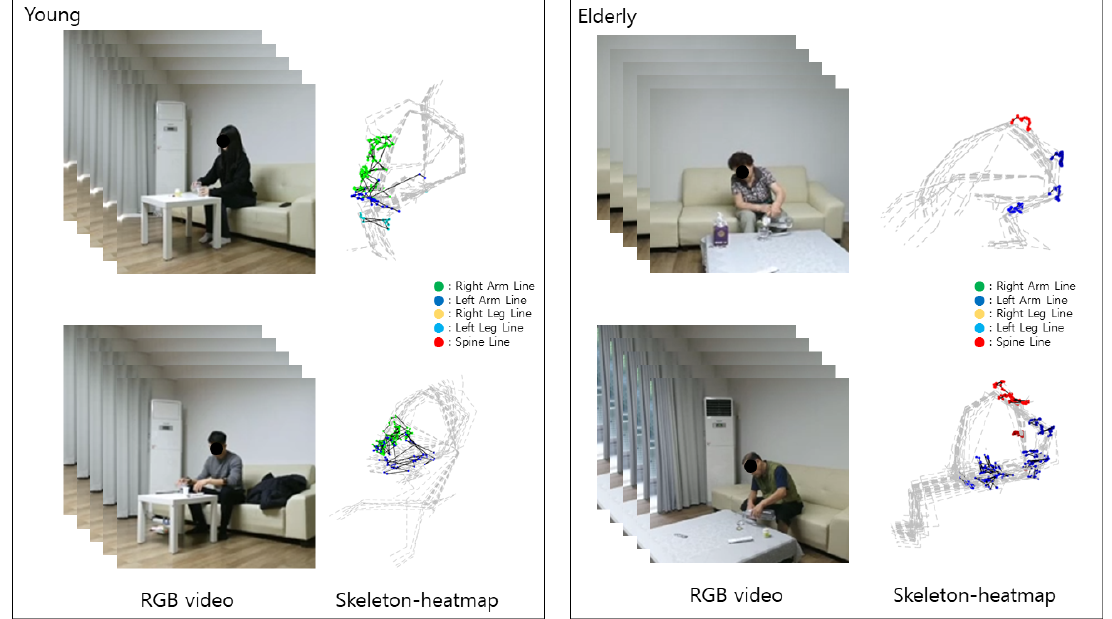
Figure 9. Video and difference matching analysis of skeleton-heatmaps between elderly people and young adults for the behavior of pouring water into a cup.